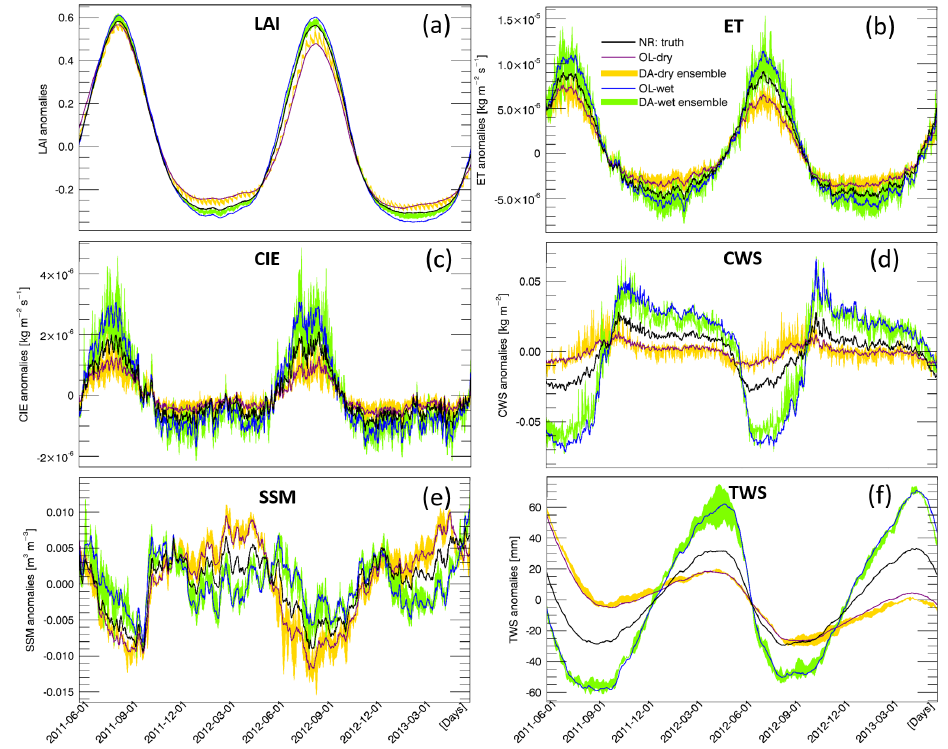
Figure 4. Global averaged daily anomalies of LAI and five water variables (1 June 2011–31 May